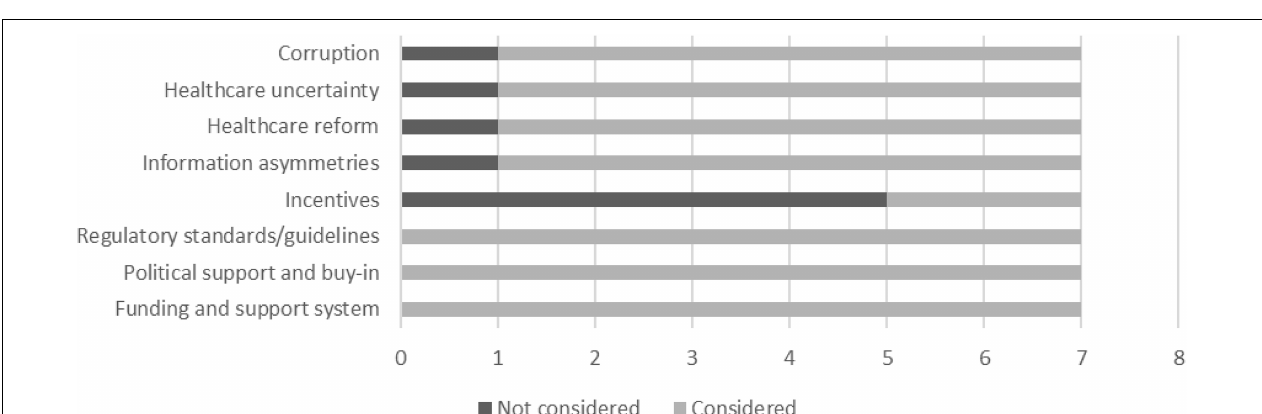
FIGURE 5 | Consideration of external influencing